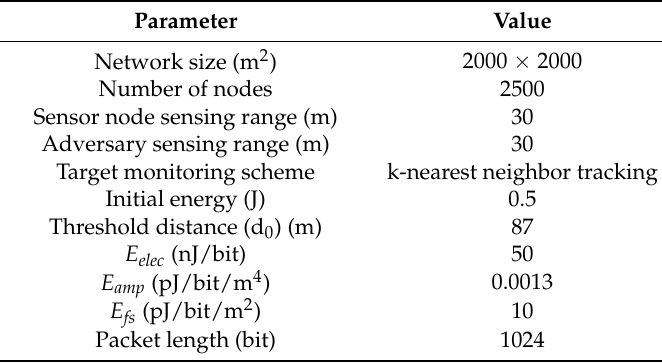
Table 1. Network simulation